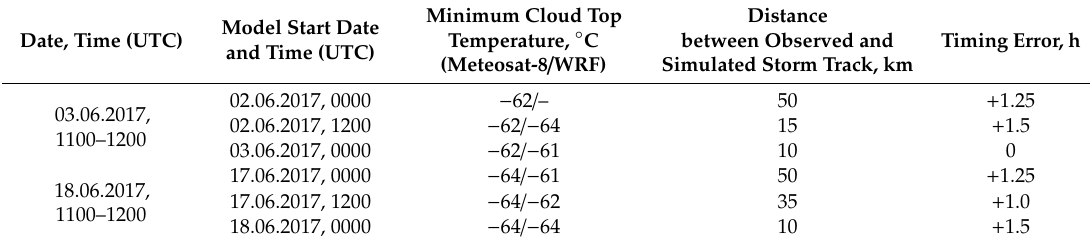
Table 6. Comparison of the storm characteristics simulated by the WRF model (with the24- and 36-h forecast lead time) with the Meteosat-8 satellite